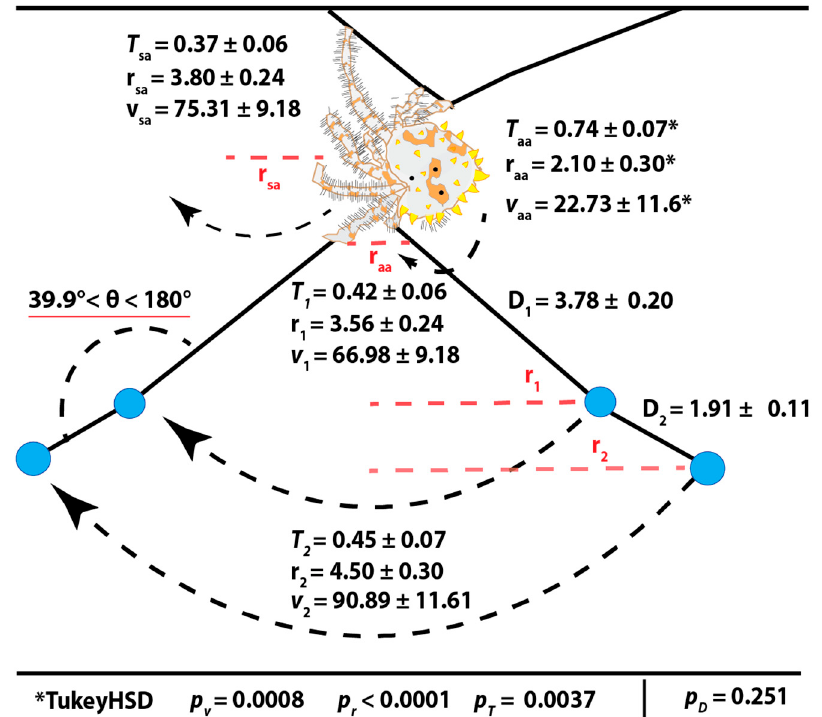
Figure 4. Average Kinematics of Spider Legs and Bolas Glue Droplets During Spinning. Post hoc Tukey analysis showed that the spinning of the anchor leg is the most statistically different for all measured values (period T in s, velocity v in cm/s, and radius r in cm). The anchor leg barely moves and completes only half a rotation for each one of the glue droplets that the swing leg completes. Though the large variation in spinning speed led to no overall difference within tests, the D 2 was always spinning faster and further out than D 1 . The angle between D 1 and D 2 can be seen changing while spinning leading to variation in the angle between them (Supplementary Data File S1, Excel Datasheet).